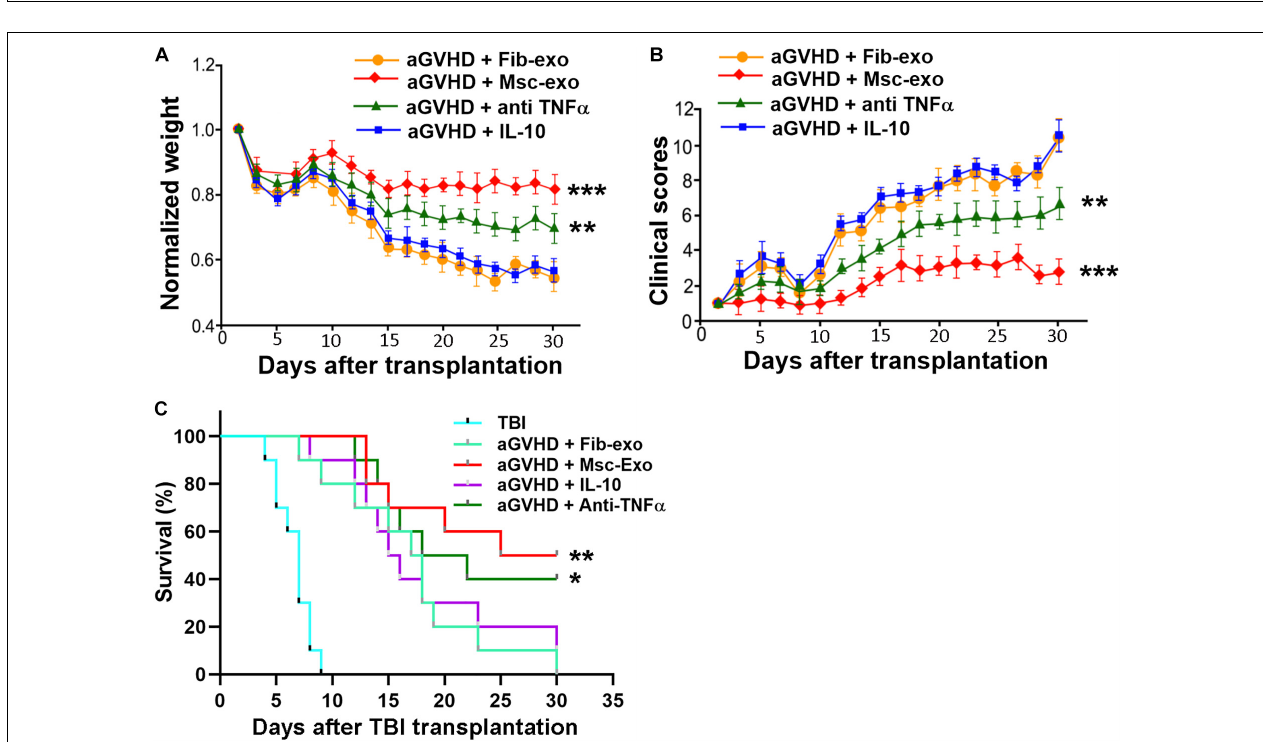
FIGURE 6 | Human bone marrow–derived mesenchymal stem cell (hBMSC)–derived exosomes alleviated the manifestations of acute graft-versus-host disease (aGVHD) in mice. Mice in the exosome injection group were injected with 200 µ g exosomes per mouse via tail vein on the day of transplantation. Recombinant mouse IL-10 was intravenously injected into aGVHD mice with a dose of 5 µ g/kg every other day (injection volume 50 µ l) in the IL-10 treatment group starting from day 0. For TNF- α inhibition, mice were injected intraperitoneally with etanercept (Merck) at a dose of 5 mg/kg body weight every 3 days starting from day 0 and the animals in the control group received injections of saline. No exosome was used in IL-10 and etanercept treated mice. (A) Weight changes of aGVHD mice in each treatment group. (B) Clinical score of aGVHD mice in each treatment group. (C) Survival curves of aGVHD mice in each treatment group. TBI, total body irradiation. *** p < 0.001, ** p < 0.001, * p < 0.05. N = 10 in each